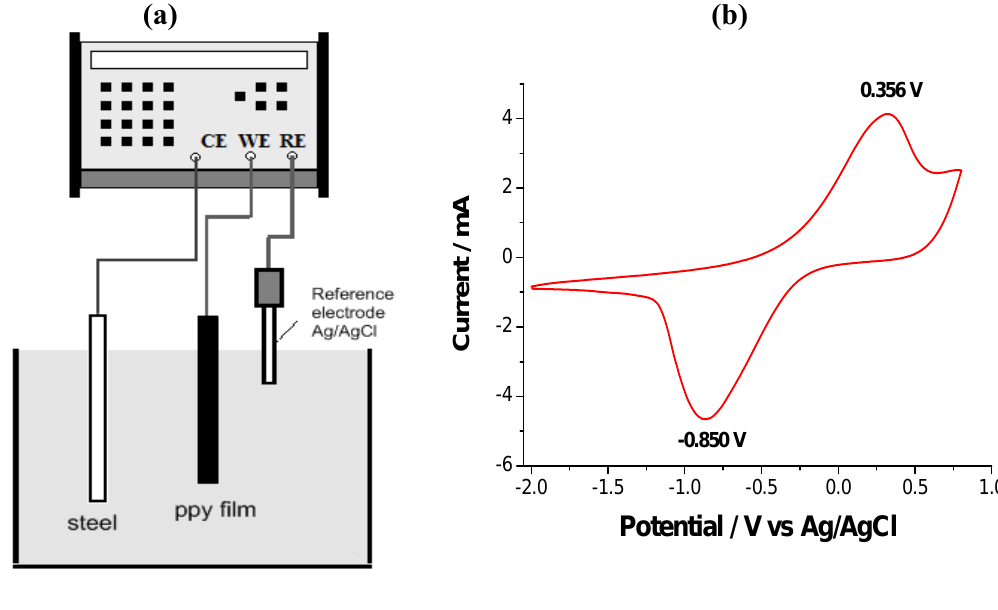
Figure 5. (a) Scheme of the electrochemical cell used to follow the electrochemical behavior of self-supported pPy/DBSA films. (b) Control voltammogram recorded at 6 mV s –1 aqueous solution at room between –2.0 and 0.80 V in 0.1 M LiClO 4